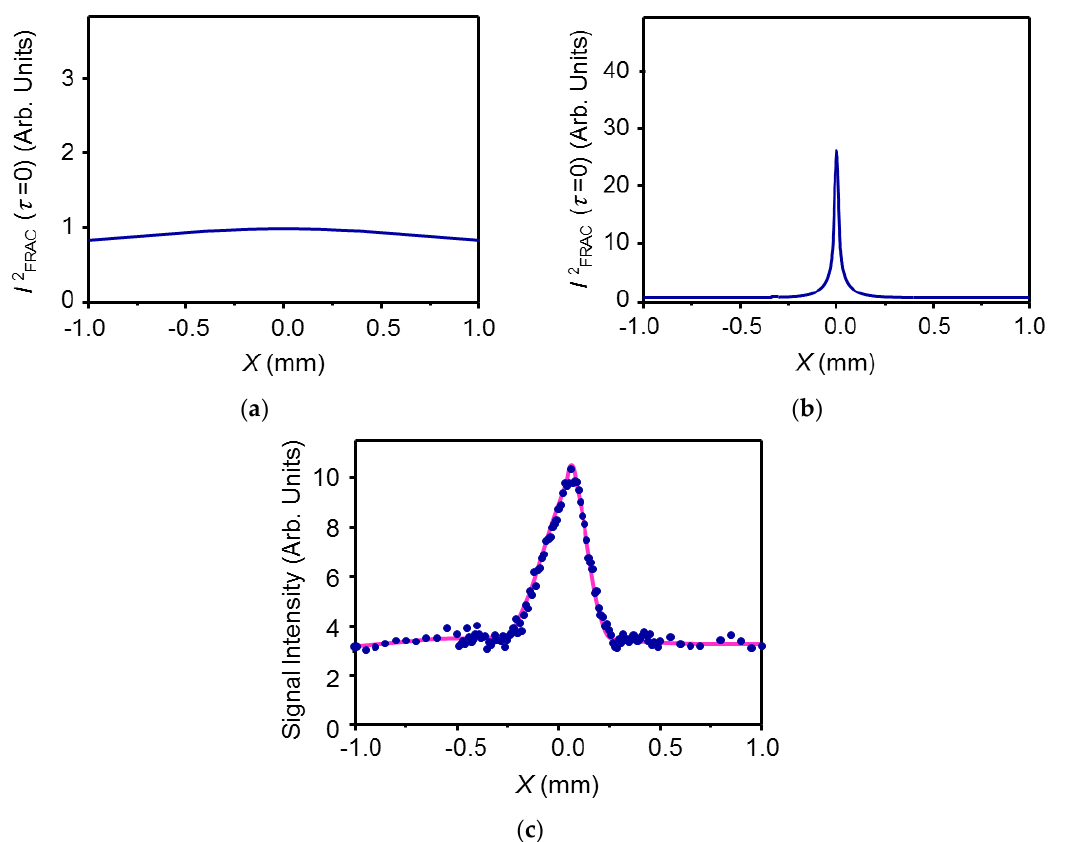
Figure 4. Calculated dependence of the parameter, I 2FRAC (τ = 0), on the parameter, X : ( a ) random phase; and ( b ) phase-locked; ( c ) Observed dependence of the signal intensity, I 2FRAC (τ = 0), on the parameter, X . The parameter of X 1/2 can be obtained by calculating the half width at the half maximum of the signal peak. In this case, a three-color beam emitting at 267, 241, and 219 nm was introduced into the molecular beam in the mass spectrometer.